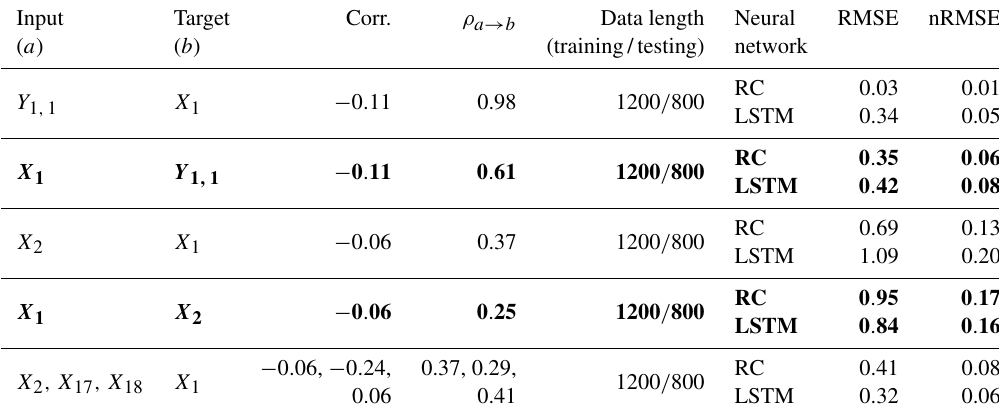
Table 3. Details of reconstructing the Lorenz 96 model. Input Target